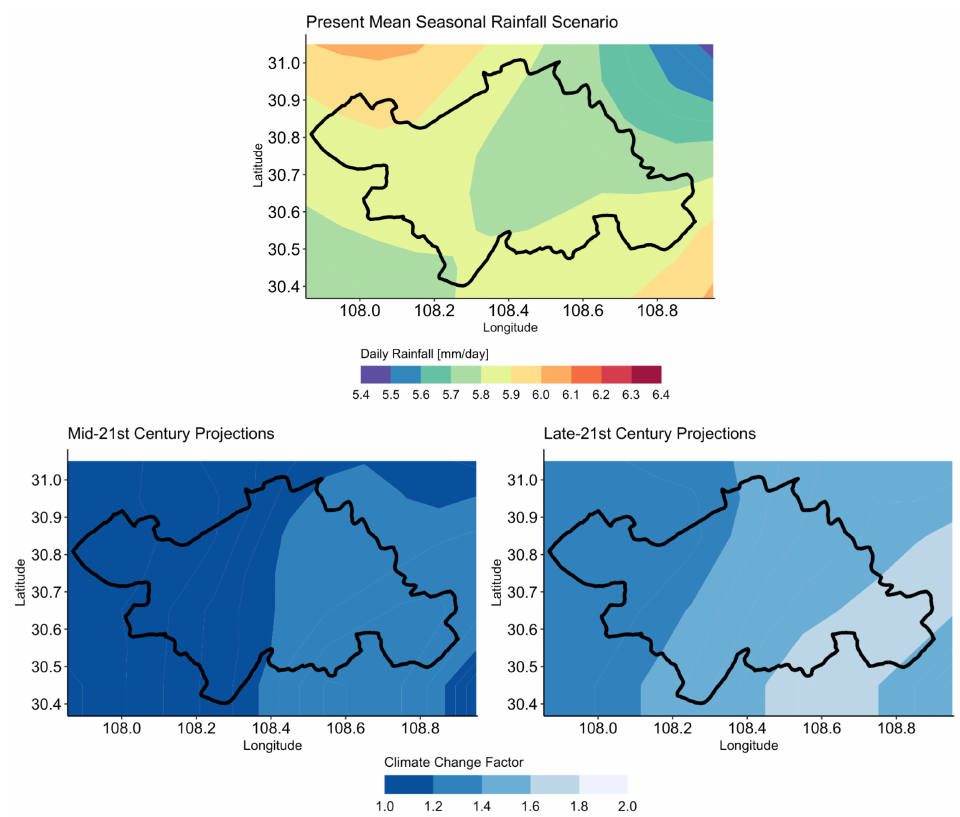
Figure 8. Reference scenario derived from mean seasonal rainfall from May to August over the period of 1979 to 2018 and the mean climate change factor from the ensemble projections of the mid-21st century and the late-21st century scenarios